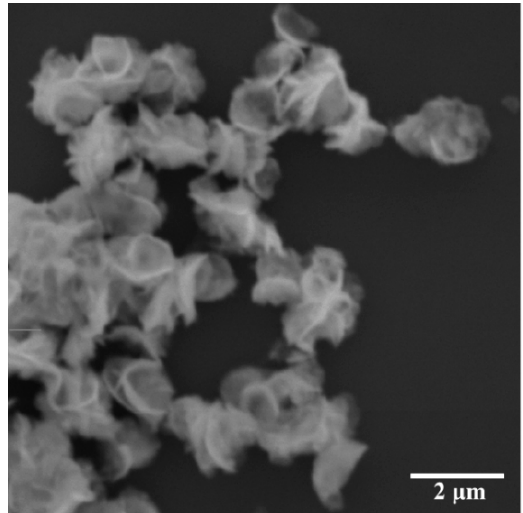
Figure 3. Bi 2 WO 6 monolayer substructure configuration of [BiO] + —[WO 4 ] 2 − —[BiO] + exposing the Bi atoms on the surface.